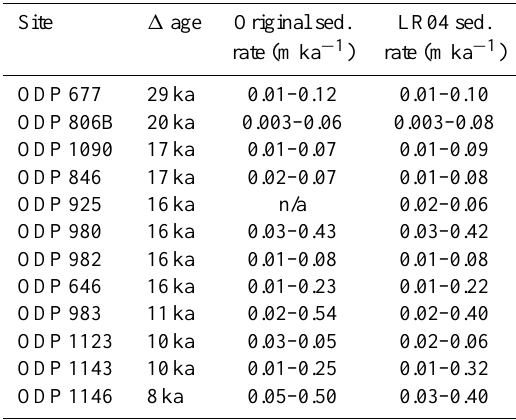
Table 2. Sediment accumulation rates from LR04 and original age models, and maximum age differences ( 1 age) between the two models. Site 1 age Original sed. LR04 sed.